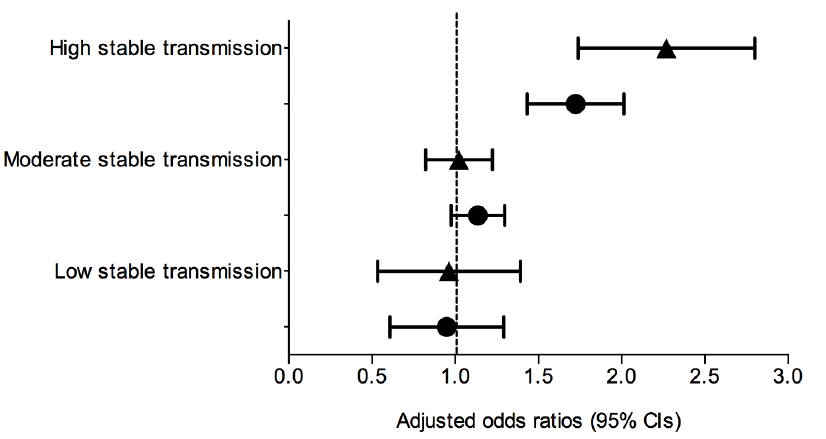
N Figure 4. Effect of maternal education on test uptake in different malaria endemicities. Figure legend: m , Secondary or higher schooling , Primary schooling versus no schooling. Mixed-effects logistic regression model in pooled dataset of 13 surveys, adjusted for versus no schooling; data clustering and Table 3 covariates. Stable transmission categories refer to low ( Pf PR 2–10 , 5%), moderate ( Pf PR 2–10 5%–40%) and high ( Pf PR 2–10 . 40%).